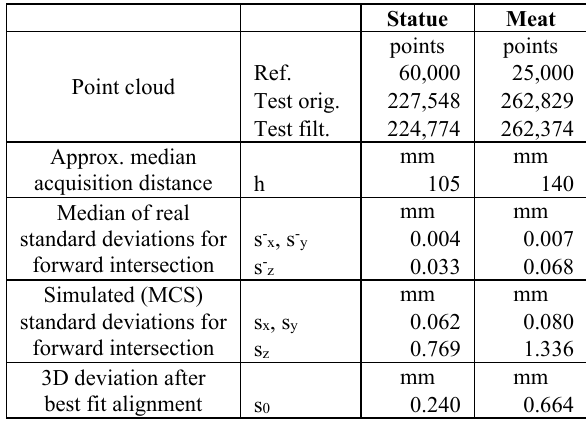
Table 1. 3D comparison and